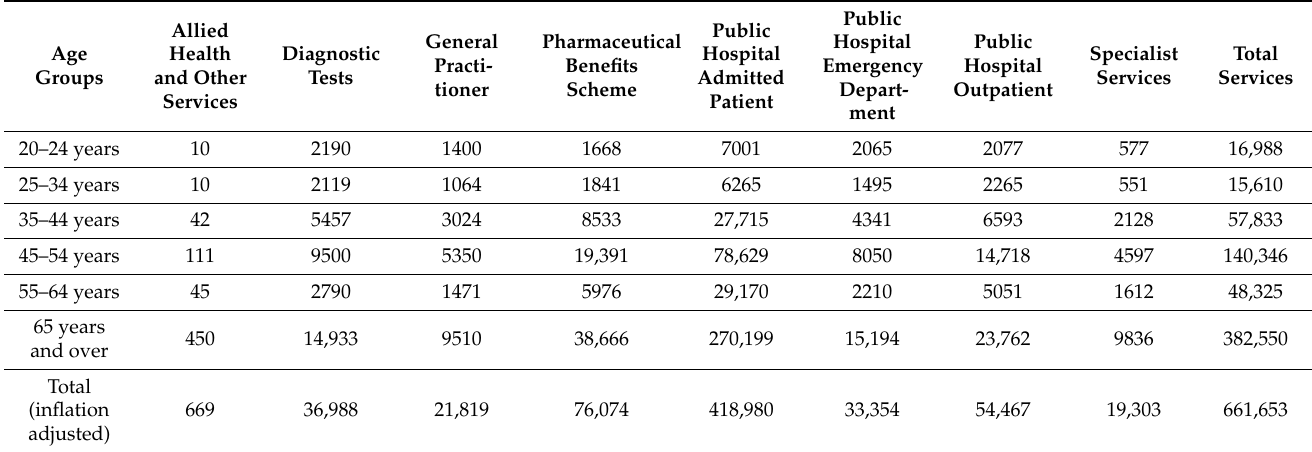
Table A12. Extra costs incurred due to LHL for people diagnosed with Chronic kidney disease in the Blacktown LGA (Domain 9).